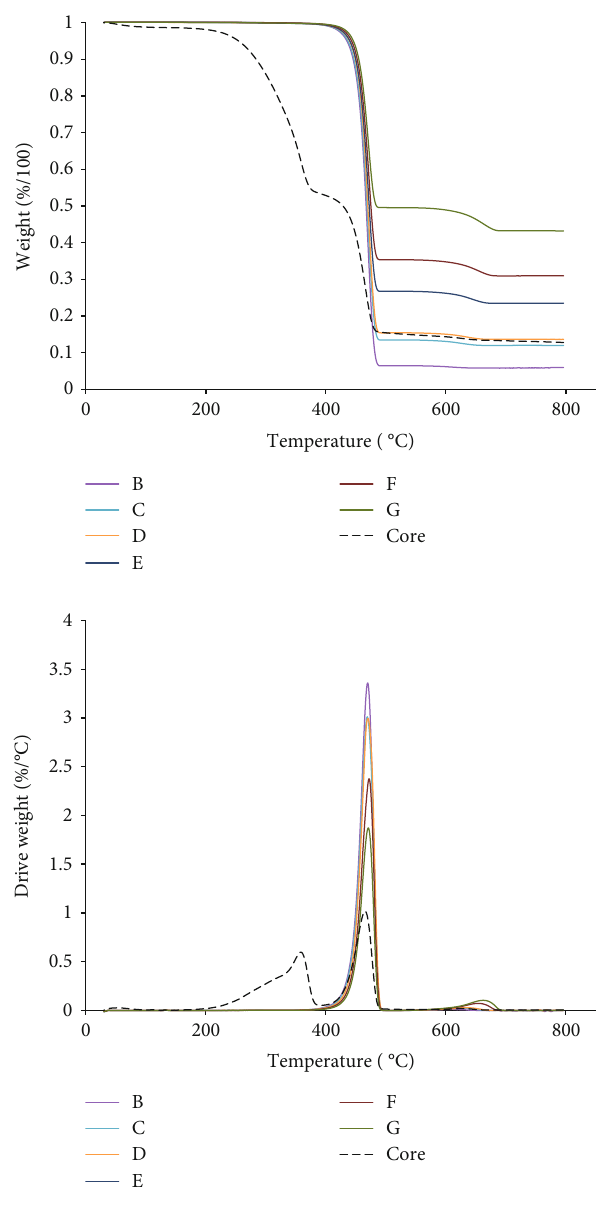
Figure 3: Decomposition curves obtained at a 5 ° C/min heating rate of core-shell composites with di ff erent talc contents in the shell in comparison with a material containing just the core (dashed